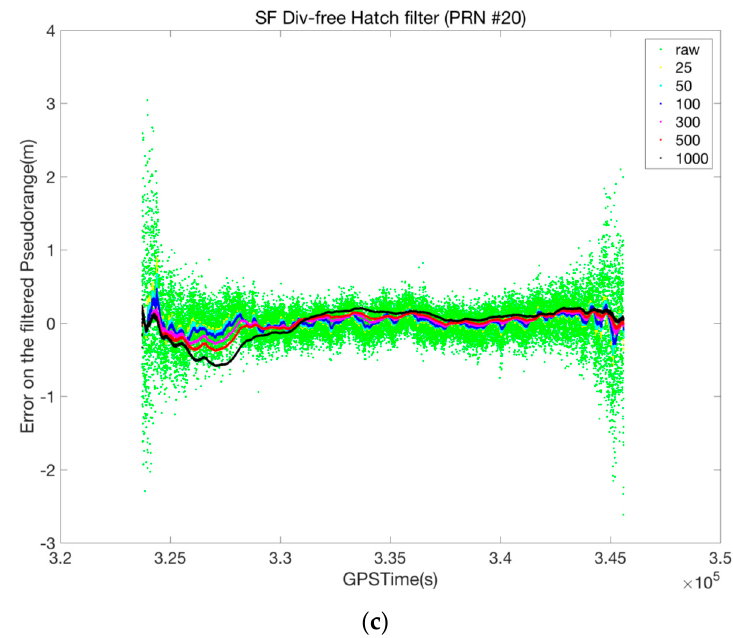
Figure 8. Smoothing filter performance for various smoothing window widths ( a ) Hatch filter; ( b ) DF divergence-free Hatch filter; ( c ) SF divergence-free Hatch filter.